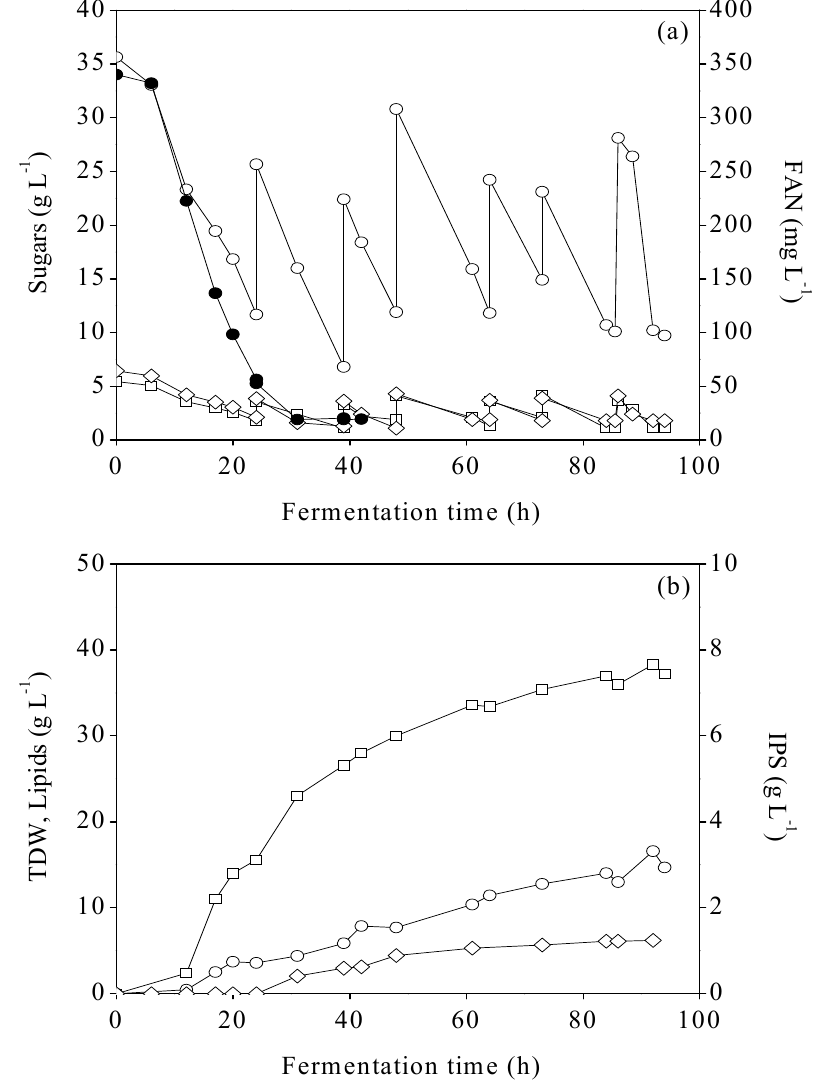
Figure 2. ( a ) Concentration of glucose ( ), fructose ( (cid:3) ), galactose ( ♦ ), free amino nitrogen (FAN) ( (cid:8) ) and Figure 2. ( A ) Concentration of glucose ( ○ ), fructose ( □ ), galactose ( ◊ ), free amino nitrogen (FAN) ( ● ) (cid:35) ( b ) production of total dry weight (TDW) ( (cid:3) ), microbial lipids ( ), intracellular polysaccharides (IPS) ( ♦ (cid:35) and ( B ) production of total dry weight (TDW) ( □ ), microbial lipids ( ○ ), intracellular polysaccharides (IPS) ( ◊ ) during fed-batch bioreactor fermentations of R. toruloides on mixed food for infants (MFI) hydrolysates.